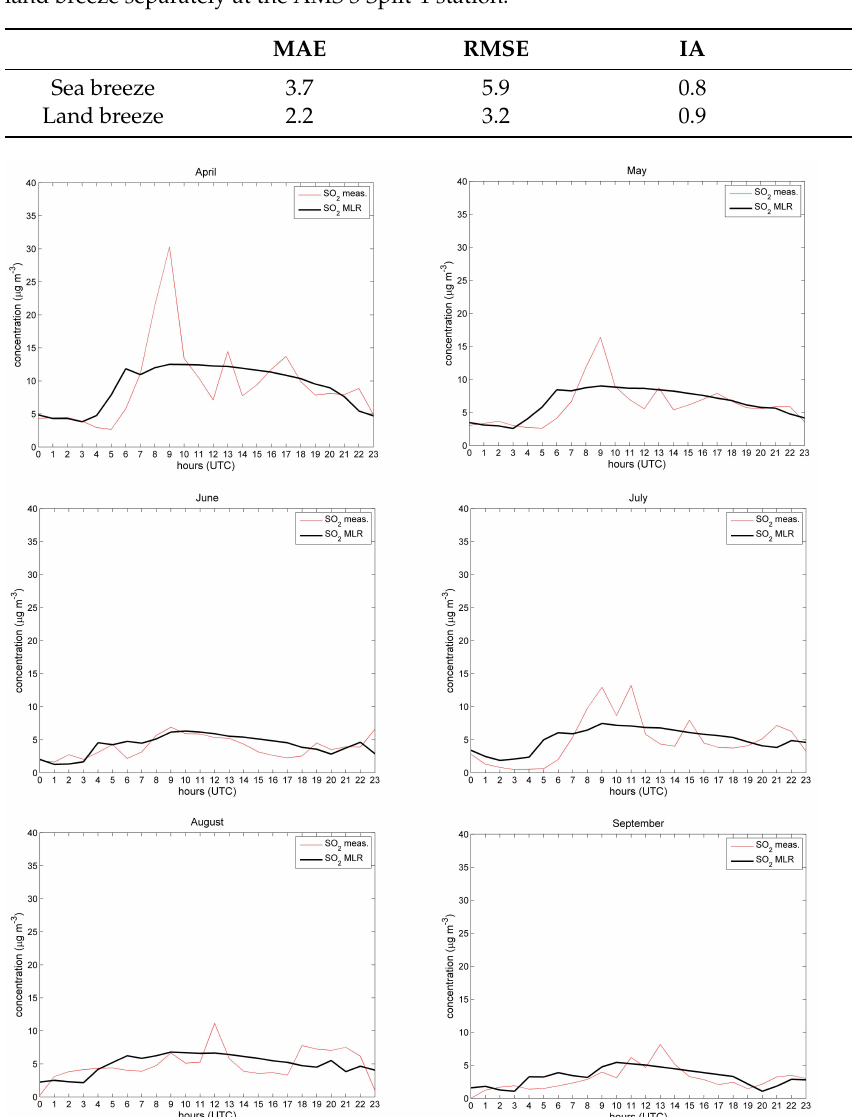
Figure 5. Mean monthly modeled and stepwise MLR-model-simulated SO 2 hourly concentrations at the AMS 3 Split-1 station from April to September